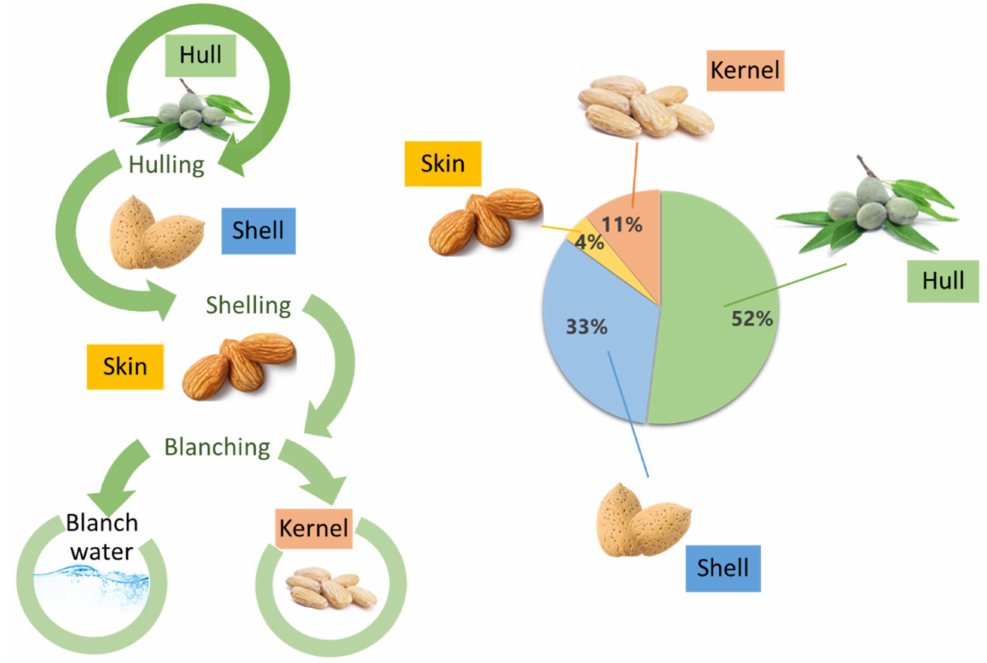
Figure 1. Generation of almond by-products (left) and proportion of constituents of almond fruits